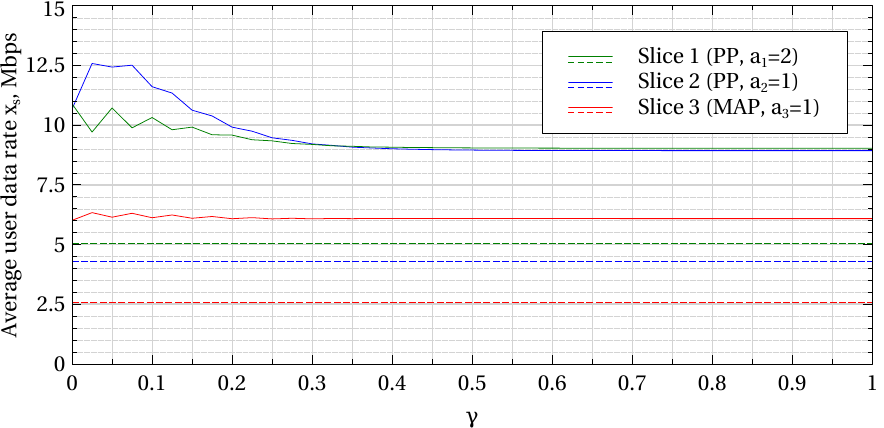
Figure 1. The blocking probabilities vs. the booked capacity shares γ s = γ , s ∈ S (solid lines—slicing, dashed lines—complete partitioning (CP)). The blocking probabilities under CP for slices 1 and 3 are not plotted due to high values and equal, respectively, 7.5 % and 16.9 %. Note that the complete sharing (CS) values coincide with that under slicing for γ = 1 and are not shown explicitly.